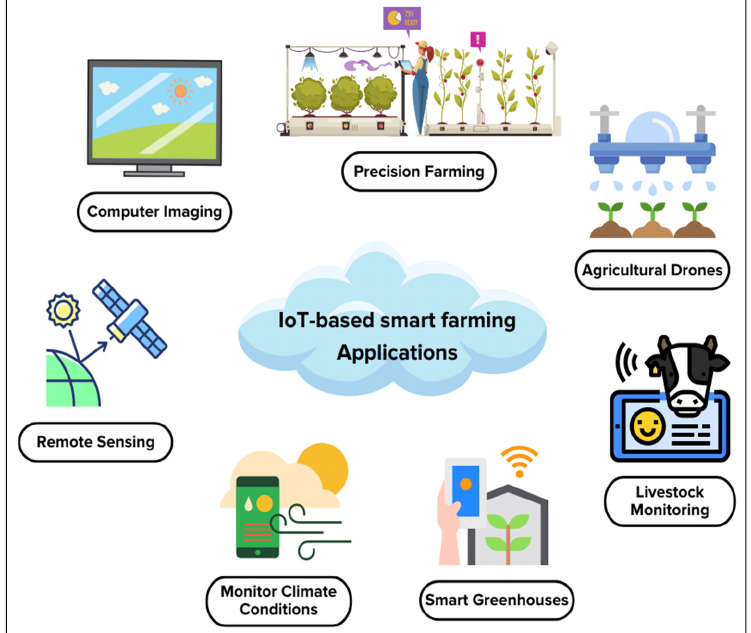
Figure 2. An exemplary hub of IoT based smart farming applications in smart